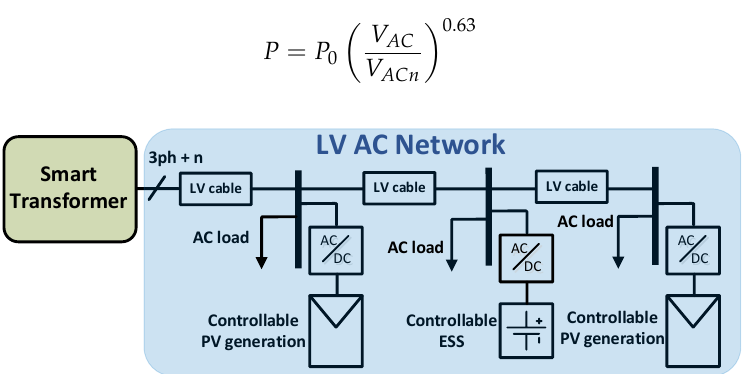
Figure 8. Diagram of the developed computational model for the LV AC network constituting the hybrid distribution grid.